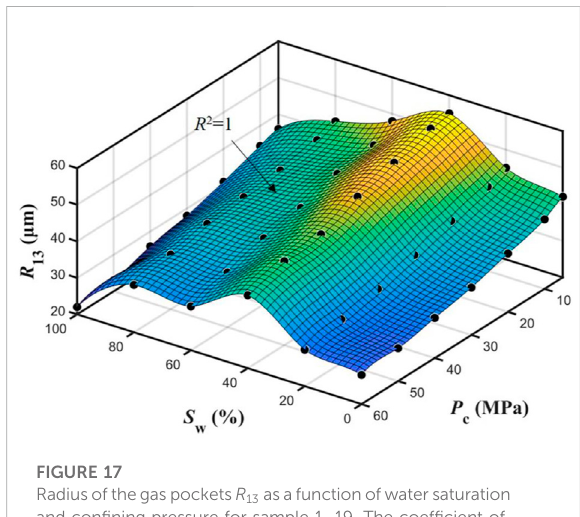
FIGURE 17 Radiusofthegaspockets R 13